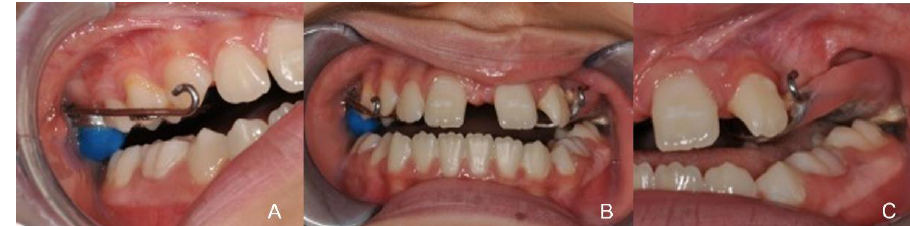
Figure 8. Intraoral images. ( A ) Right lateral view; ( B ) Frontal view; ( C ) Left lateral view